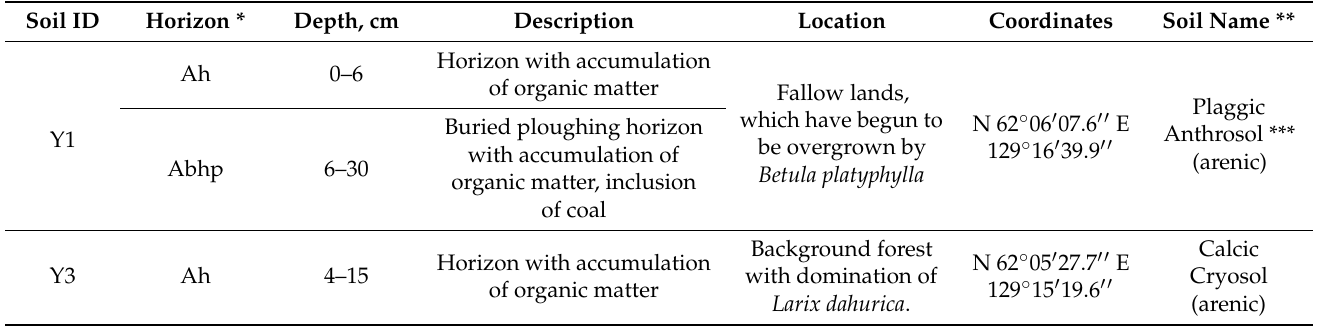
Table 1. The characteristics of fallow, arable and pyrogenic soils used for micromorphological in- vestigation.